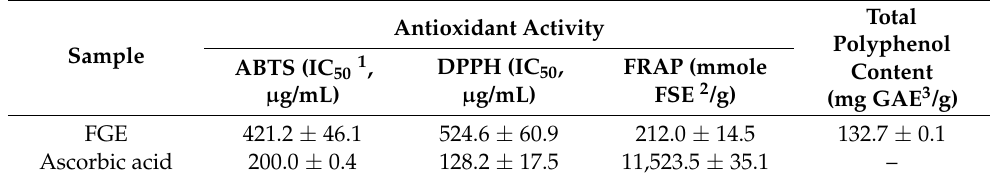
Table 1. Antioxidant activities and total polyphenol content of Filipendula glaberrima Nakai extract.